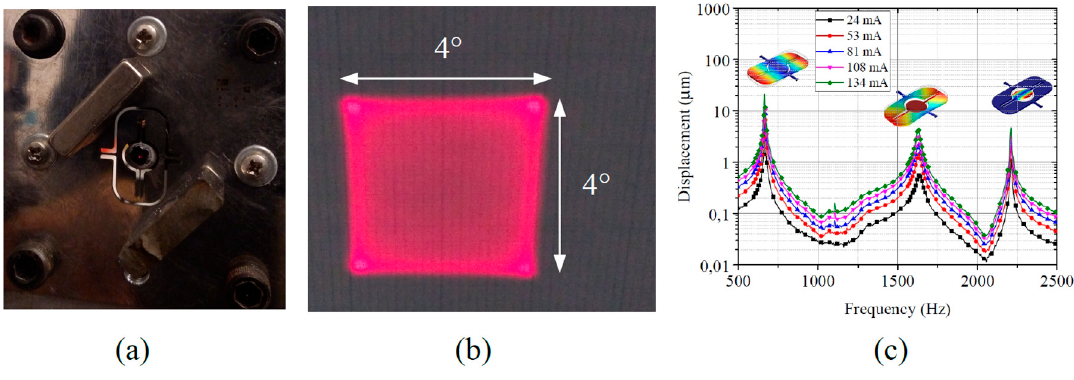
Figure 2. ( a ) Fabricated stainless-steel scanner with attached permanent magnets; ( b ) Lissajous pattern with the corresponding total optical scan angles; ( c ) Frequency response of the ss micro-scanner for varying electrocoil current